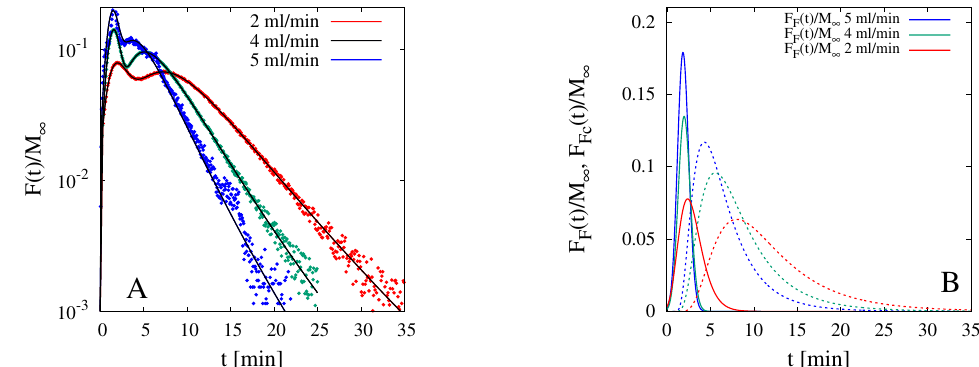
Figure 10. Analysis of rescaled differential release curves in MFTD for GG-6%Gly films loaded with the complex Flu/HP- β -CD. ( A ) Log-normal plot of F ( t ) / M ∞ vs. t for Q = 2,4, 5 mL/min. ( B ) F F ( t ) / M ∞ and F Fc ( t ) / M ∞ vs. t [min], Equation (29), for Q = 2,4,5